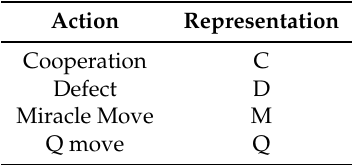
Table 7. Representation of quantum actions using letters.